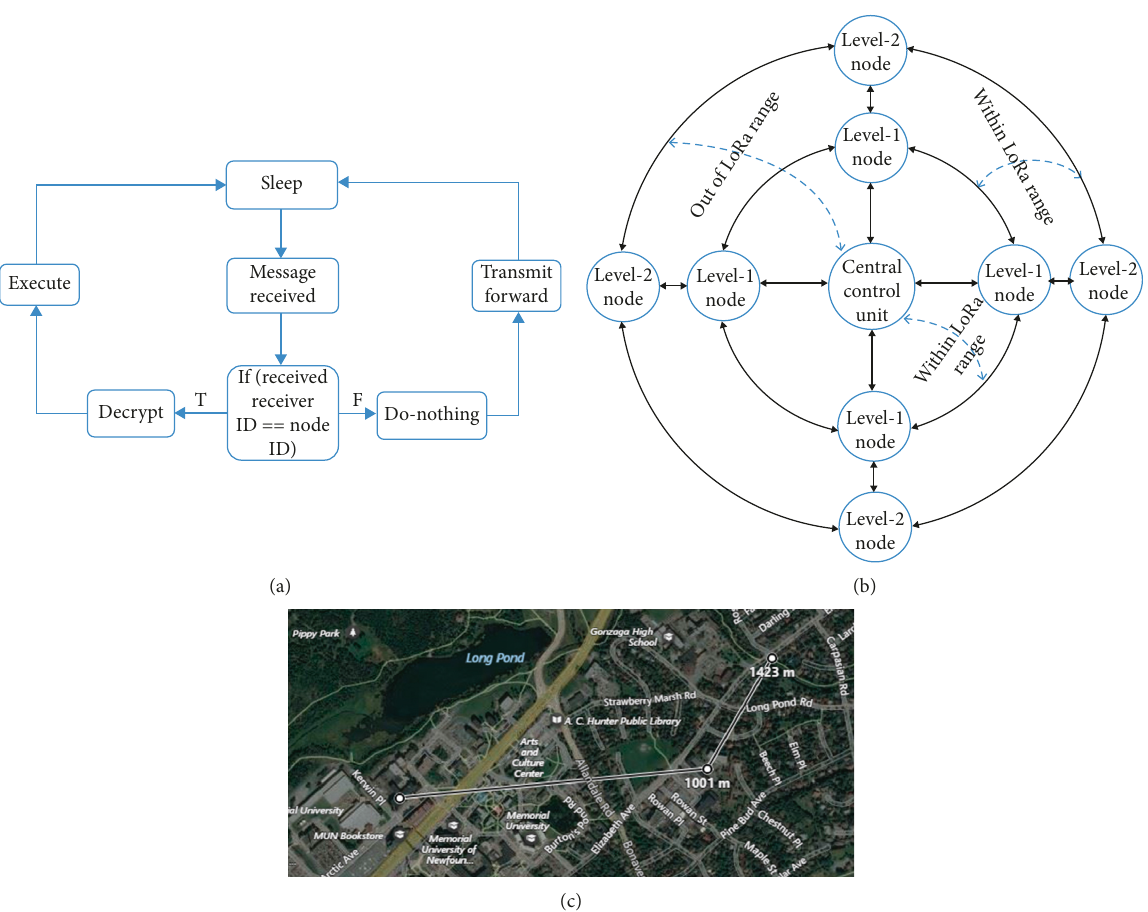
Figure 11: (a) Process flow chart for an intermediate level node. (b) Mesh network for improved LoRa range. (c) Range testing after implementing a mesh network.